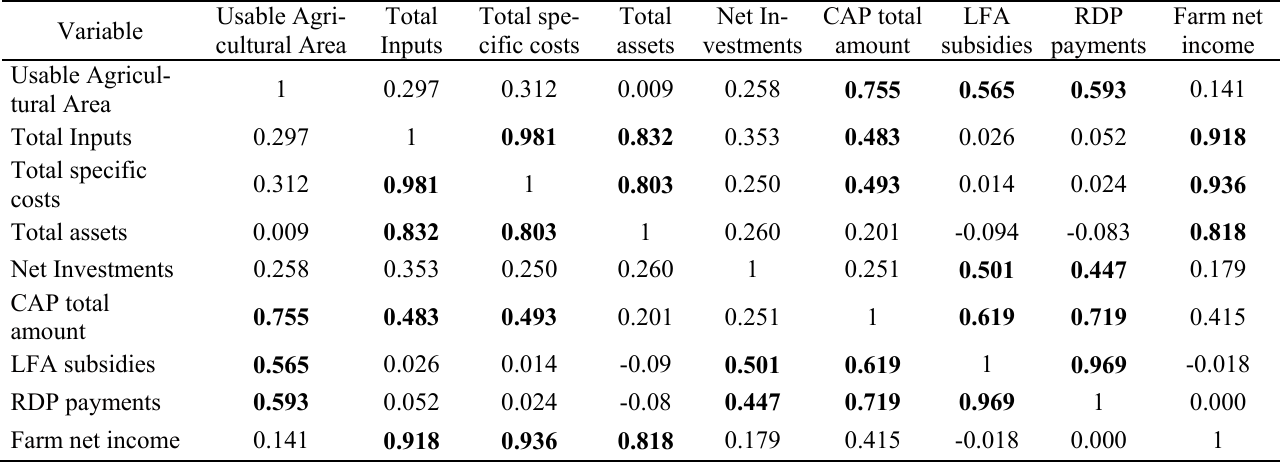
Main correlations among all investigated variables year 2016. In bold are value at a level of significance 5% (Source: author’s elaboration on data http://ec.europa.eu/agriculture/rica/database/database_en.cfm)